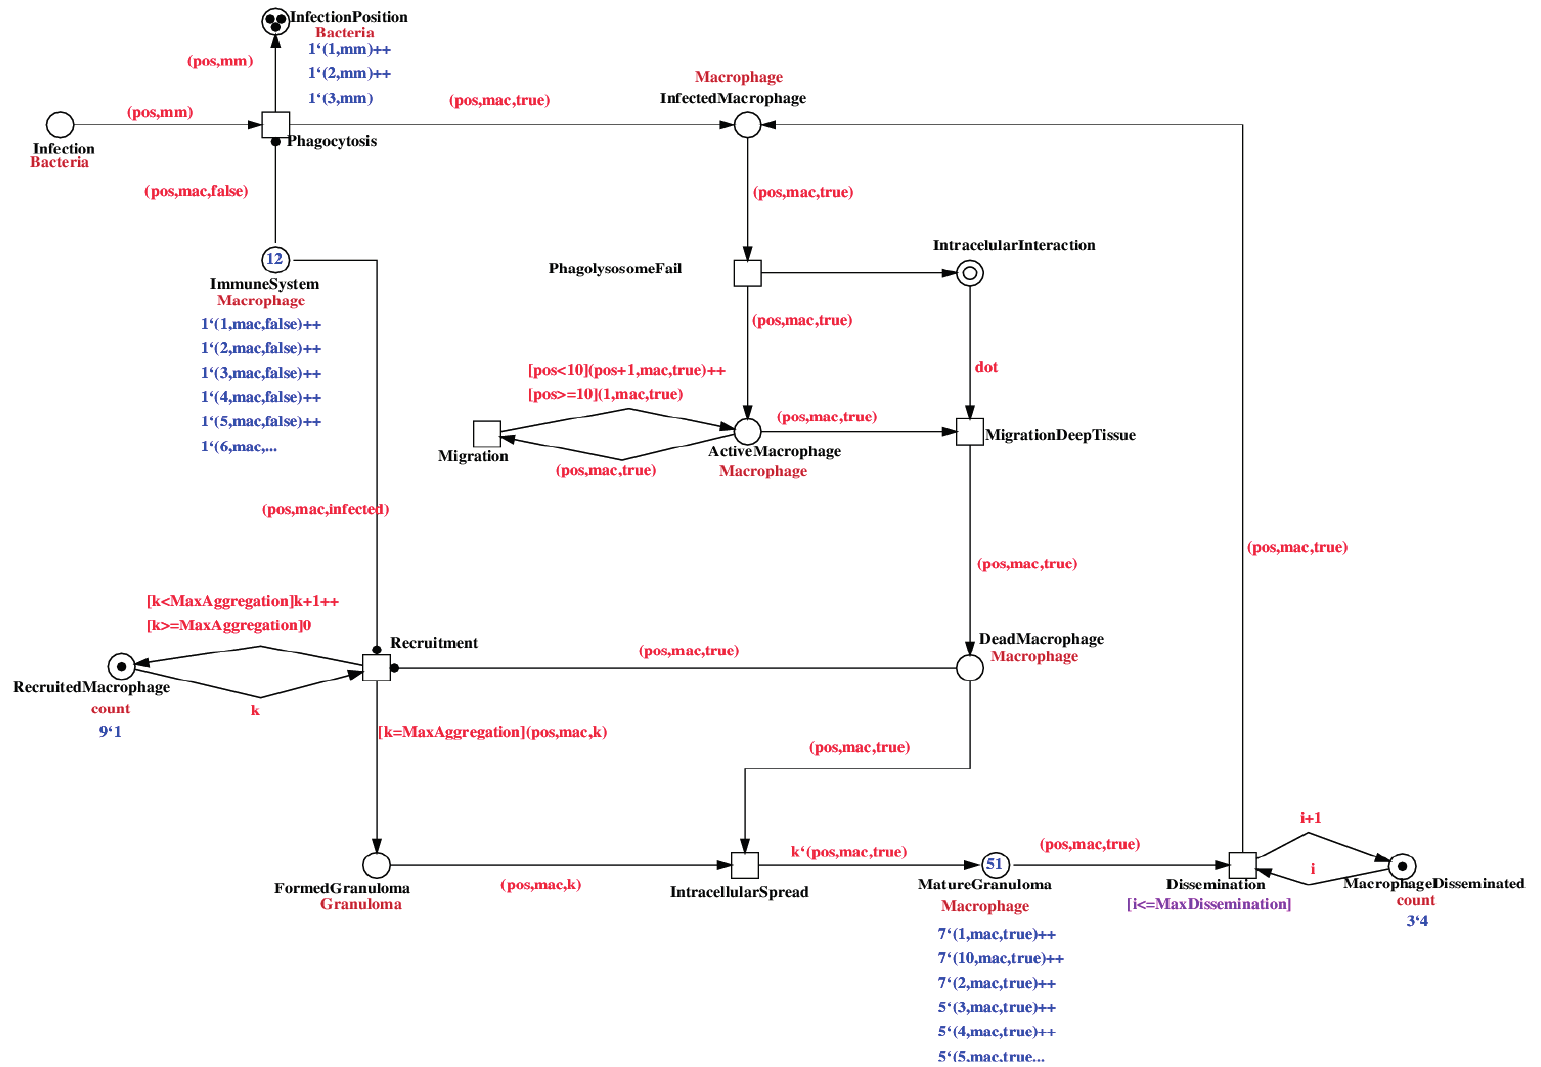
Figure 6. Animation mode at its final state, where there are no more enabled transitions to occur. We save this state and use the file as input to our 3D visualization